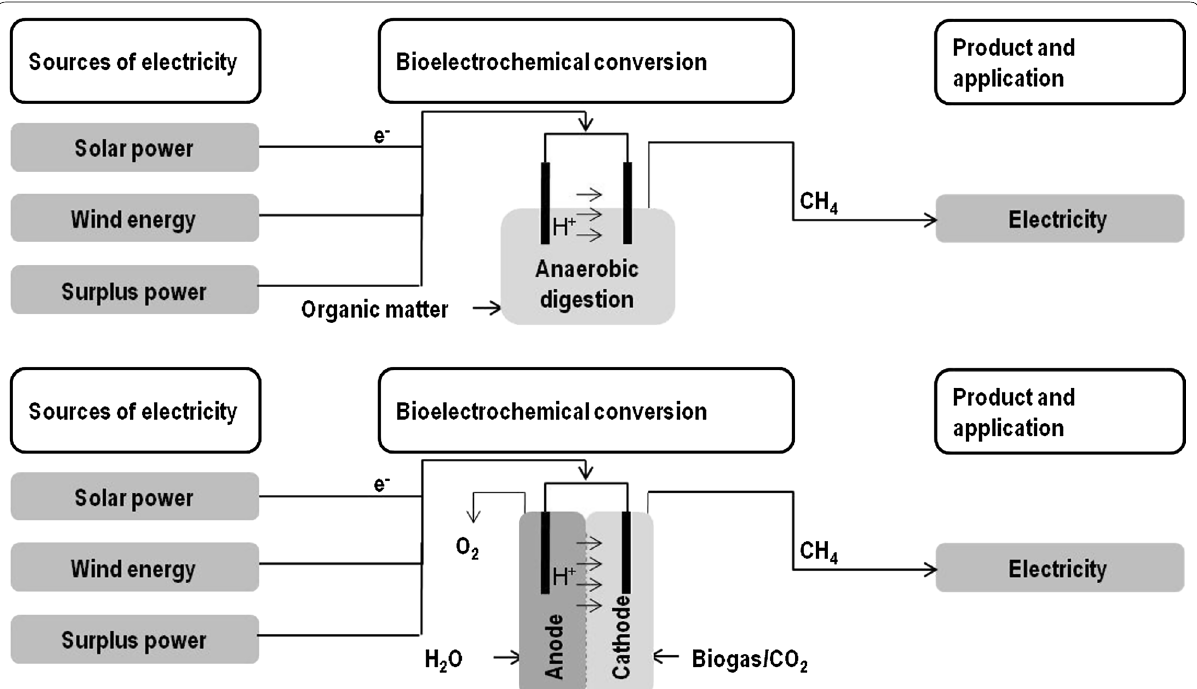
Fig. 6 Increasing methane yield by electrode integration. Top: integration of electrodes into the anaerobic digester; bottom: biogas upgrading in an external, separated MES system fed with CO 2 and